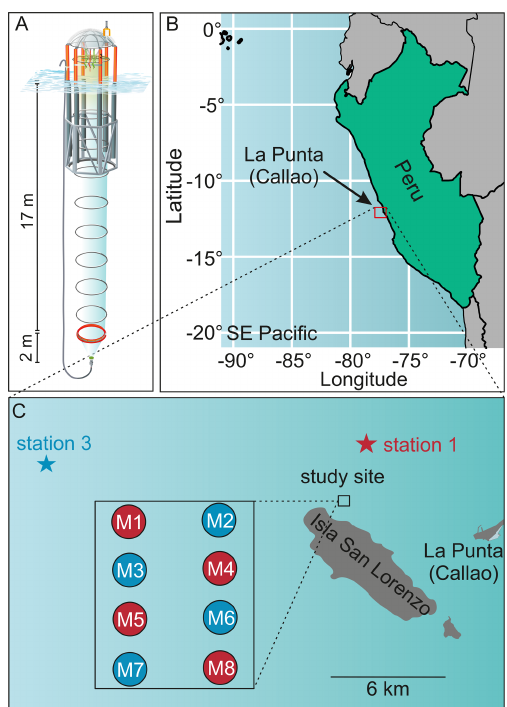
Figure 1. Study site of the mesocosm experiment. (a) One KOS- MOS mesocosm unit with dimensions of the polyurethane bag and of the sediment trap. We acknowledge reprint permission of parts of this graphic from the AGU (Bach et al., 2016). (b) Location of the study region off La Punta (Callao). IMARPE and the laboratories for sample processing were located in La Punta (Callao). (c) En- larged map of the study site that was located at the northern end of San Lorenzo Island. The additional square shows the mesocosm setup. OMZ water masses were collected at the IMARPE perma- nent stations 1 and 3 indicated by the stars. This figure is a reprint of Bach et al.